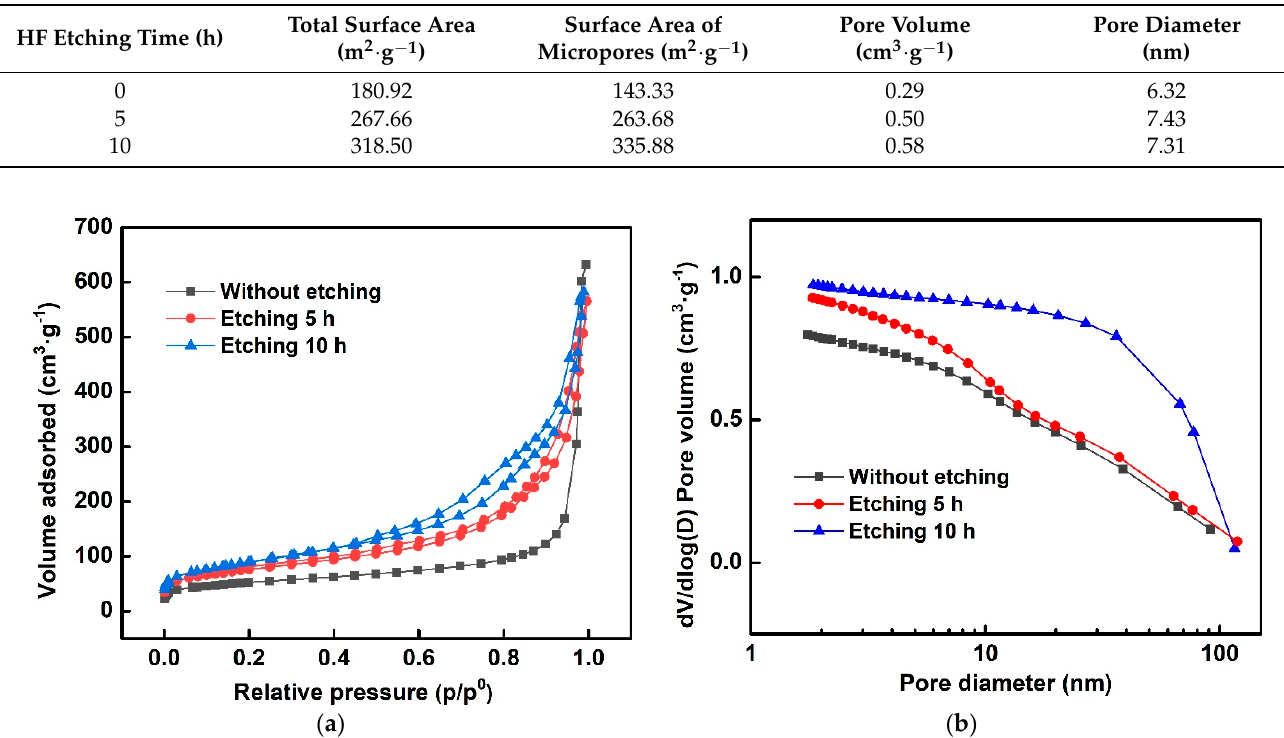
Figure 2. ( a ) N 2 absorption–desorption isotherms and ( b ) pore size distributions of S-C. Table 1. Pore structure parameters of various S-Cs with different HF etching